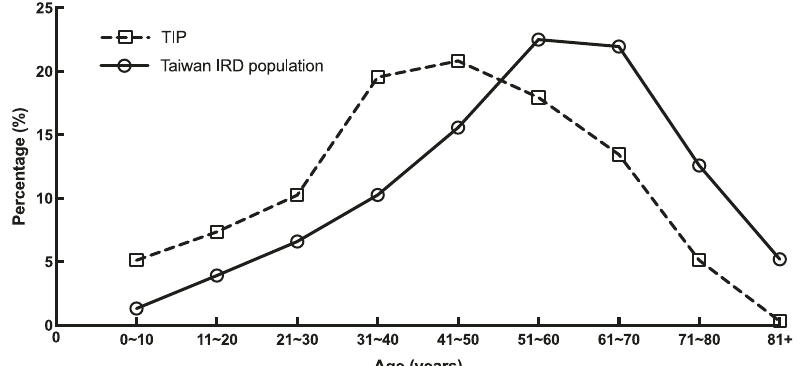
Fig. 5 Age distribution of TIP and Taiwan population. Age distribution of our cohort (TIP) and the Taiwan IRD population based on the National Health Insurance Research Database (NHIRD) of